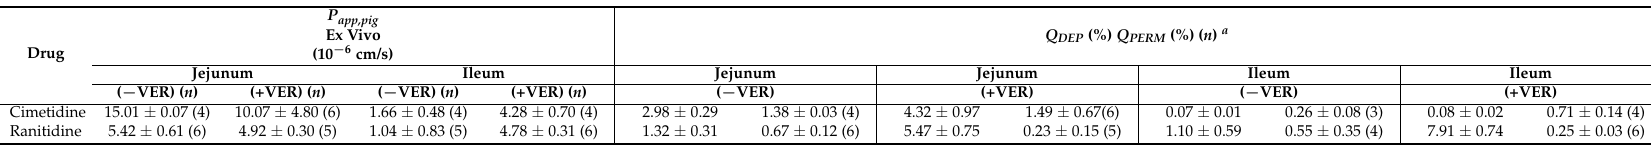
Table 4. The apparent drug permeability coefficients, P app,pig and Q DEP and Q PERM , in the jejunum and ileum for the drug substrates of the P-gp efflux transporter in the presence (+VER) and absence ( − VER) of the P-gp inhibitor,